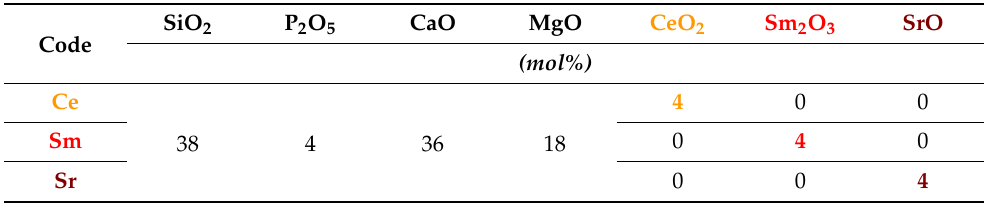
Table 1. Oxide compositions of the developed